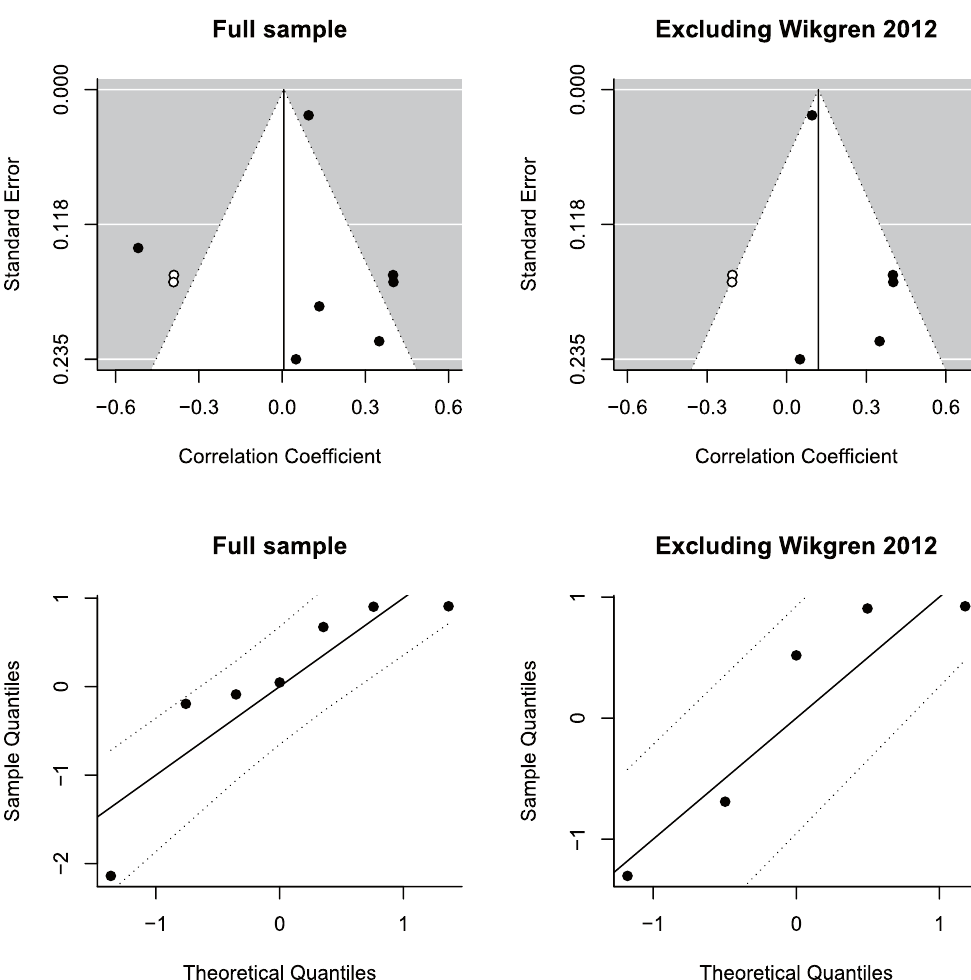
Figure 3. Funnel plots and Q-Q plots. Funnel plots show that the sample was right-skewed. Trim-and-fill analysis imputed two additional studies (unfilled circles) both in the full sample and in the reduced sensitivity analysis sample. Q-Q plots show that in the full sample, there was deviation from linearity due to one study. When this study was removed in the sensitivity analysis, linearity was acceptable.